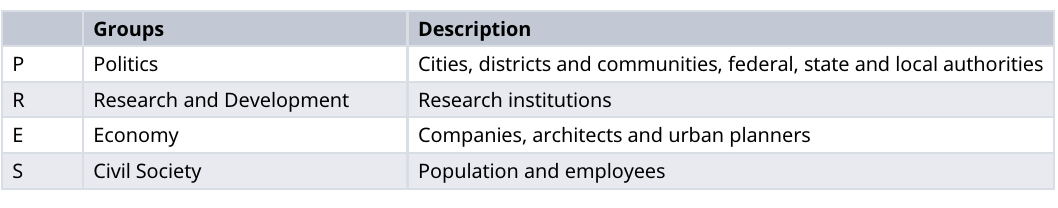
Table 1. Groups of stakeholders.